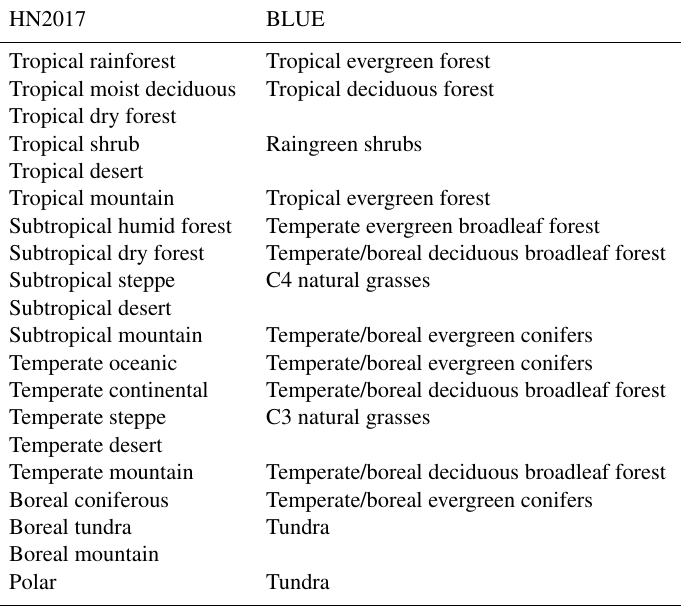
Table A1. Plant functional types in HN2017 and in BLUE, and the correspondence used in this